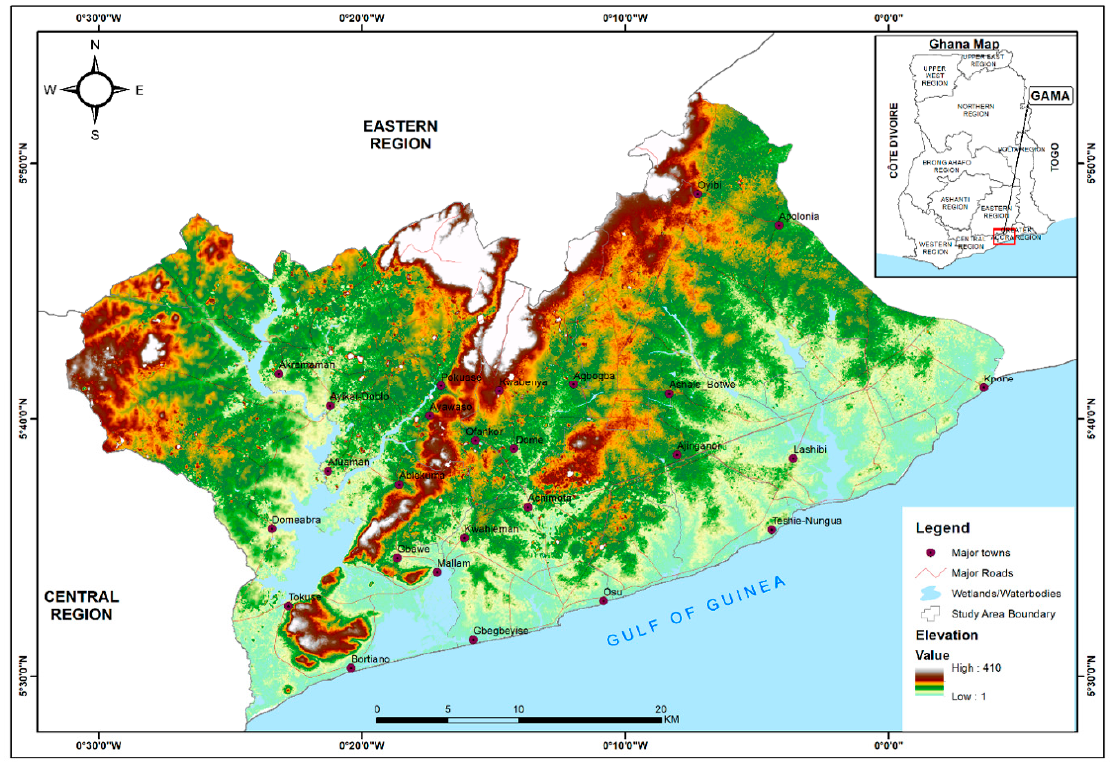
Figure 1. Study area location.